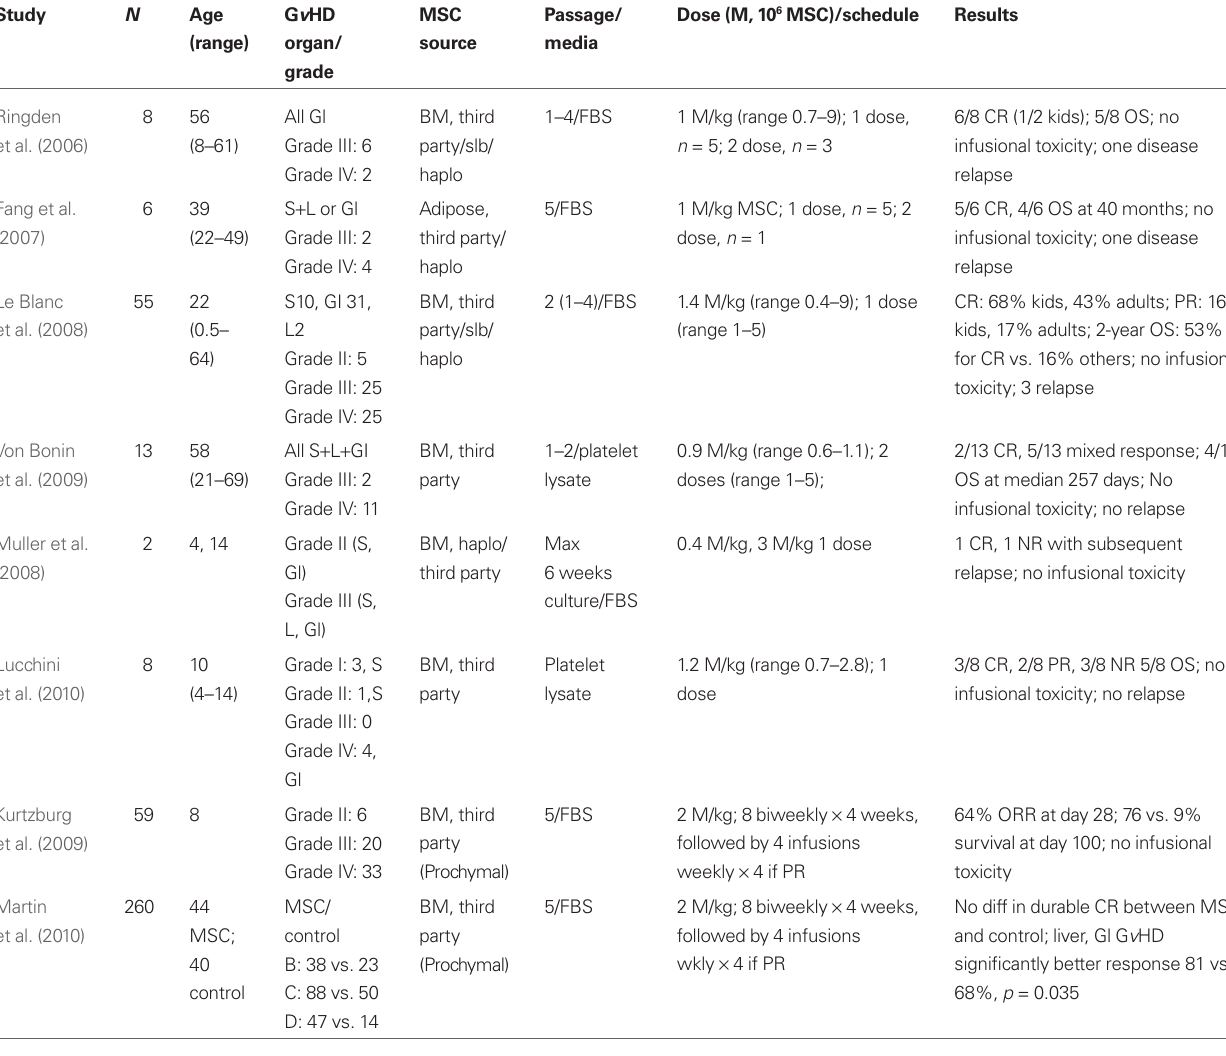
Table 1 | Results of clinical trails utilizing MSC for steroid-refractory acute G v HD.